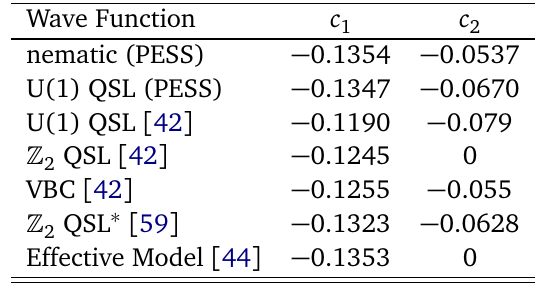
Table 2: The c , c coefficients of the Taylor expansion for the BKH model at large 1 2 breathing limit obtained with PESS ( D = 13) compared with those of the DMRG data for the effective model in Ref. [ 44, 58 ] (after extrapolation to infinite cylinders) as well as with the (cid:90) , U(1) QSLs and VBC states of Ref. [ 42 ] and (cid:90) 2 Wave Function c